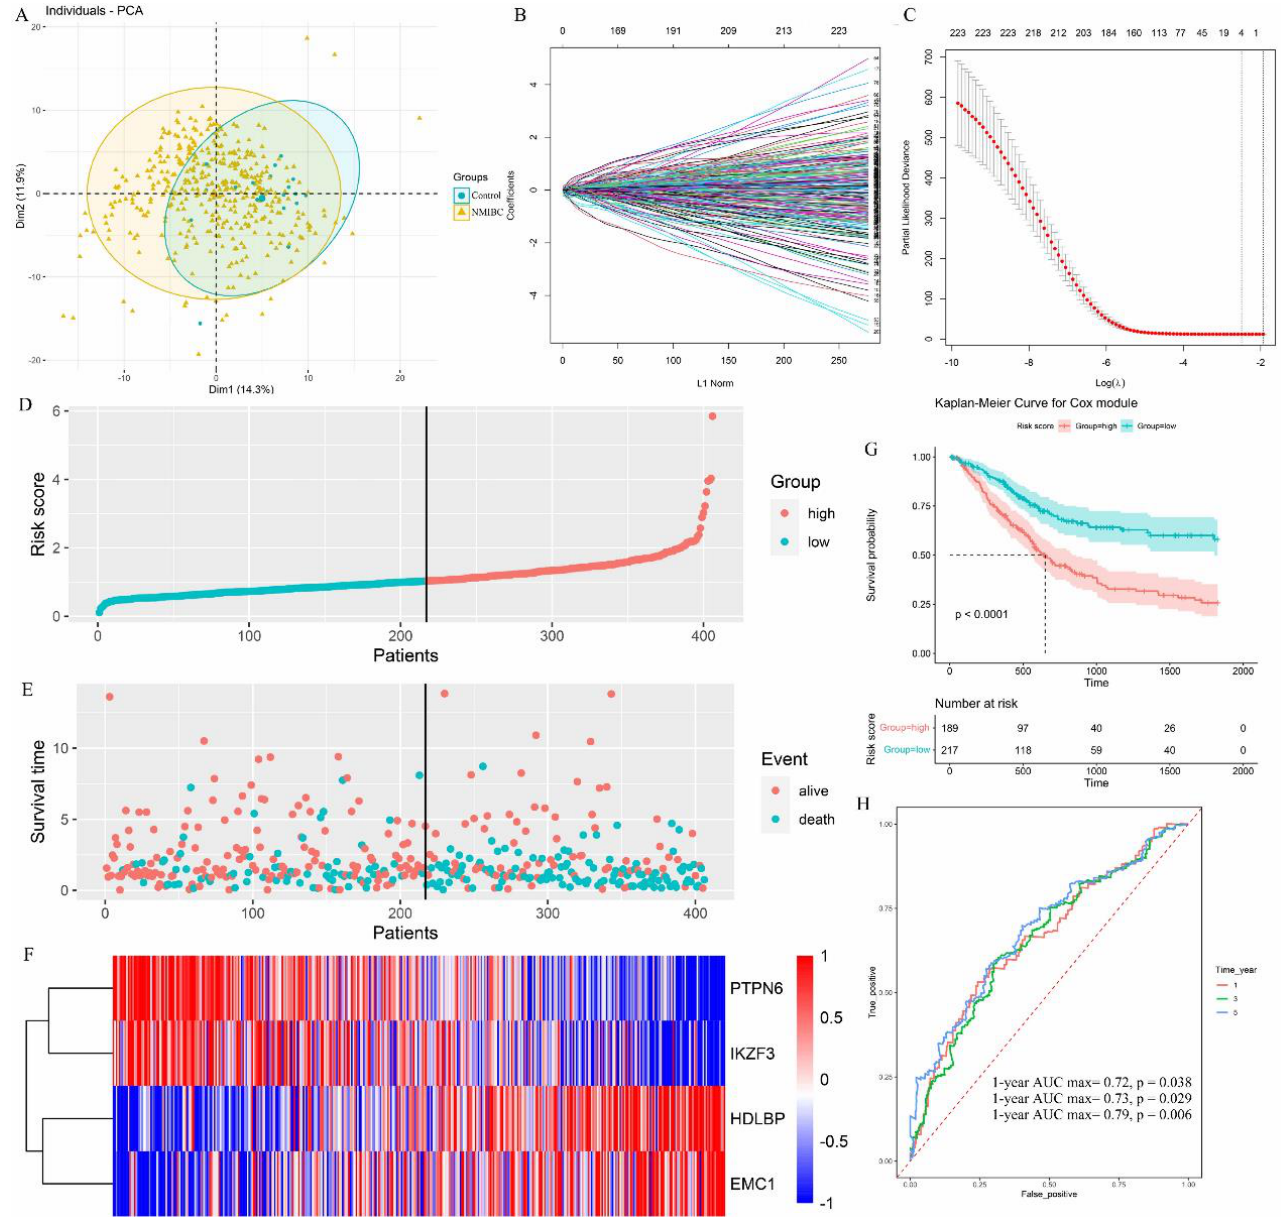
Figure 5. Identification of NMIBC occurrence-associated Eubacterium sp. CAG:581 signature in the larger population. ( A ) The result of PCA analysis demonstrating the efficacy of the Eubacterium sp. CAG:581 signature to distinguish NMIBC from the healthy control. ( B ) LASSO coefficient profiles of the prognostic DEGs. Each curve represents a coefficient, and the x -axis represents the regularization penalty parameter. As the tuning parameter ( λ ) changes, a coefficient that becomes non-zero enters the LASSO regression model. ( C ) Cross- validation to select the optimal λ. The red dotted vertical line crosses over the optimal log λ, which corresponds to the minimum value for multivariate Cox modeling. The two dotted lines represent one standard deviation from the minimum value. ( D ) The distribution of risk scores is shown for Cohort 2. The dotted horizonal line indicates the cut-off level of the risk score used to stratify patients, and the dotted vertical line separates participants on the basis of low risk (green) or high risk (red). ( E ) The distribution of overall outcomes in Cohort 2. NMIBC patients with a low-abundance of Eubacterium sp. CAG:581 are shown in green, while NMIBC patients with high-abundance of Eubacterium sp. CAG:581 are shown in red. ( F ) Heatmap of ECM1, MMP9, PTPN6, and IKZF3 in Cohort 2. Gene copy numbers are transformed as log2 ratios per gene (blue, decrease; red, increase). ( G ) Kaplan – Meier survival plots to predict patients at risk for NMIBC occurrence in Cohort 2. The number of patients remaining at a particular timepoint is shown at the bottom. ( H ) Time-dependent ROC curves for predicting one-year, two-year, and three-